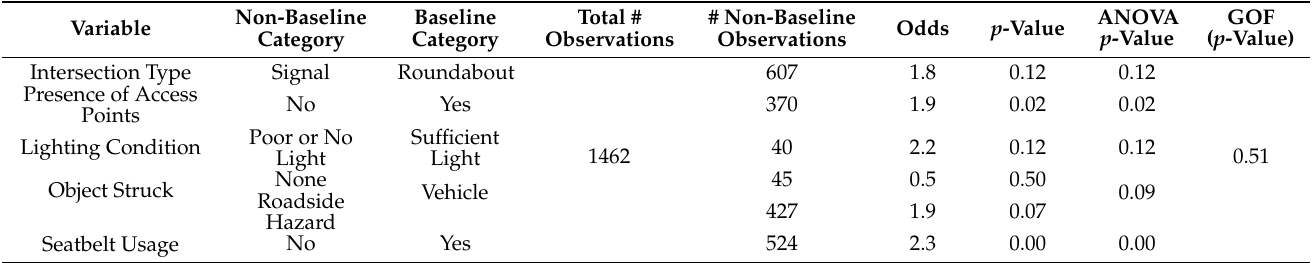
Table 8. Multivariate Roundabout